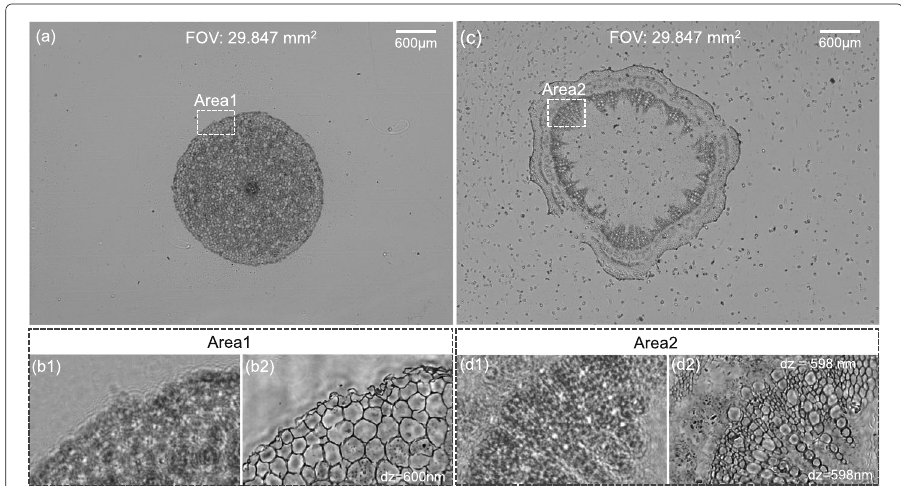
Fig. 30 Comparison of reconstructed intensities of soybeans stem crosscut and dicot root without and with digital refocusing. (a) The raw captured diffraction image over the full FOV of soybeans stem crosscut without digital refocusing. (b1) The sub-region image of the raw captured image in (a). (b2) The sub-region image of the reconstructed intensity of soybeans stem crosscut with digital refocusing. (c) The raw captured diffraction imageofdicotrootoverthefullFOVwithoutdigitalrefocusing.(d1)Thesub-regionimageoftherawcaptured image in (c). (d2) The sub-region image of the reconstructed intensity of dicot root with digital